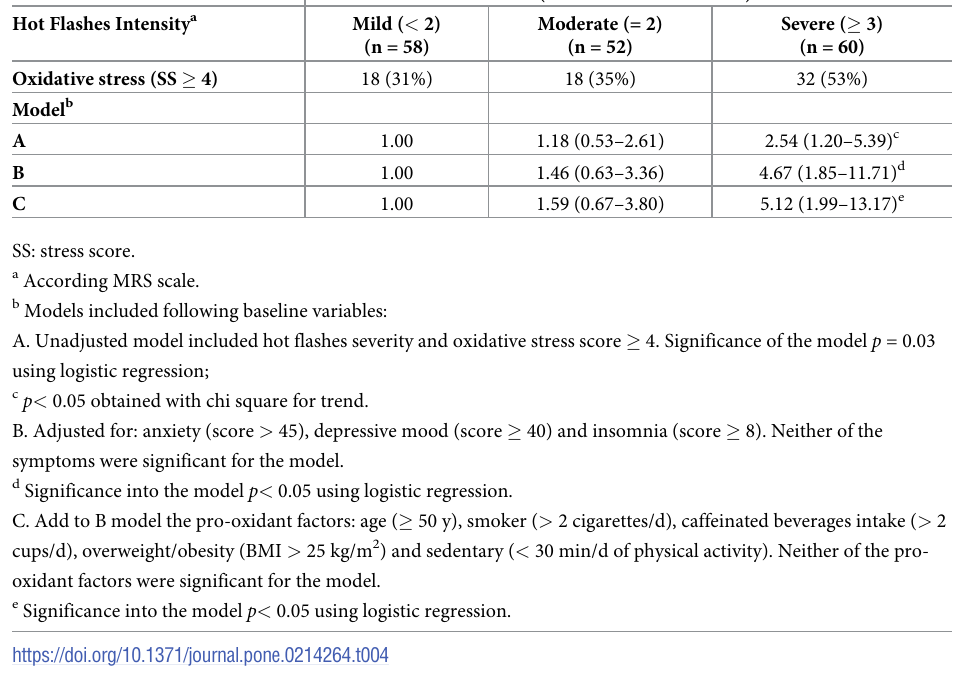
Table 4. Odds ratio to present different intensities of hot flashes according to oxidative stress and pro-oxidant factors in postmenopausal women. Hot Flashes Intensity